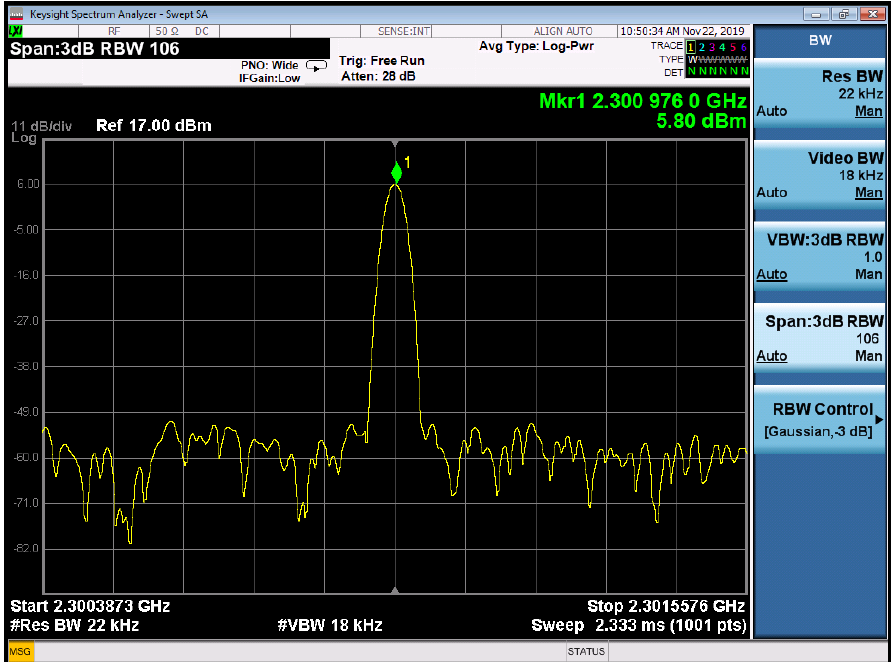
Figure 12. Spectrum radiated by RABE at 2.300 GHz. Image obtained from the signal analyzer with the prototype transmitting a single tone with a frequency of 2.300